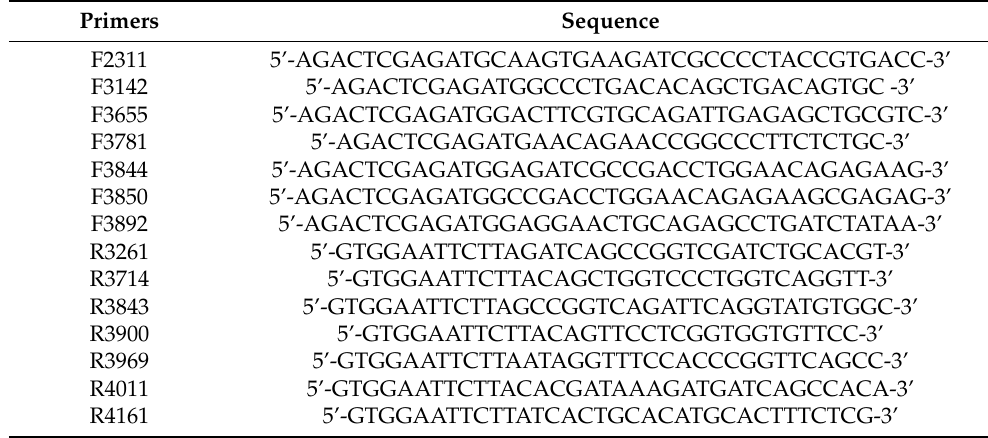
Table 1. Oligonucleotide Primers Used for Amplified PEDV S